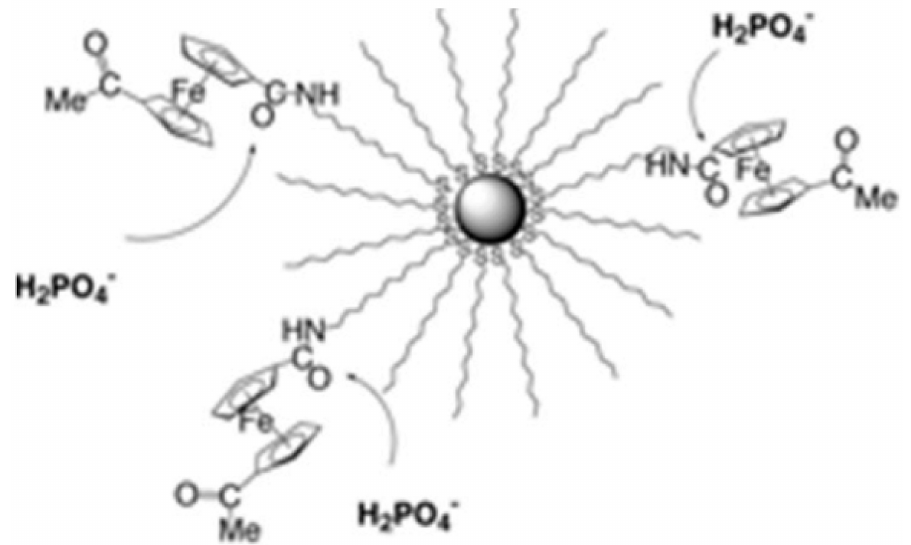
Figure 12. Scheme of Amidoferrocenate Au NP and H 2 PO 4 anions identification, reproduced under reference permis- sion [106], ACS, 2002.